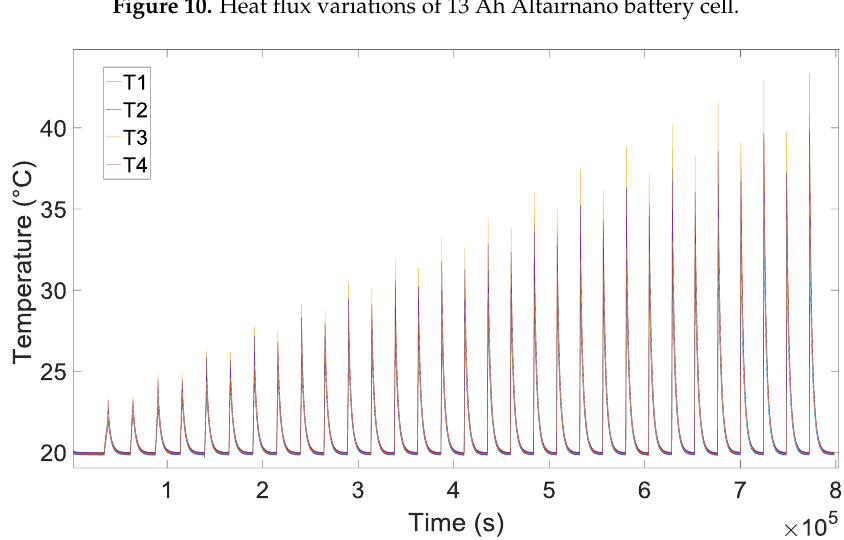
Figure 11. Surface temperature of the 13 Ah Altairnano battery cell.